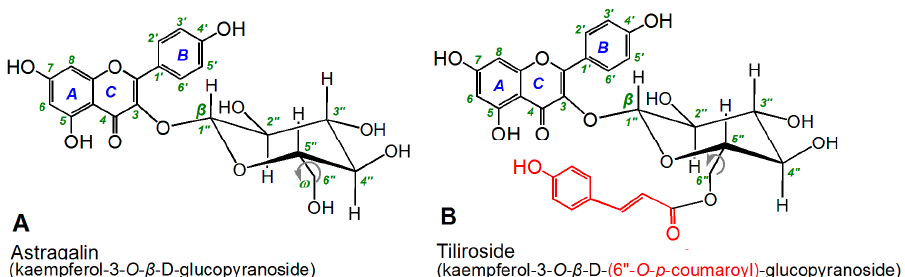
Figure 1. Structures of astragalin ( A ) and tiliroside ( B ).